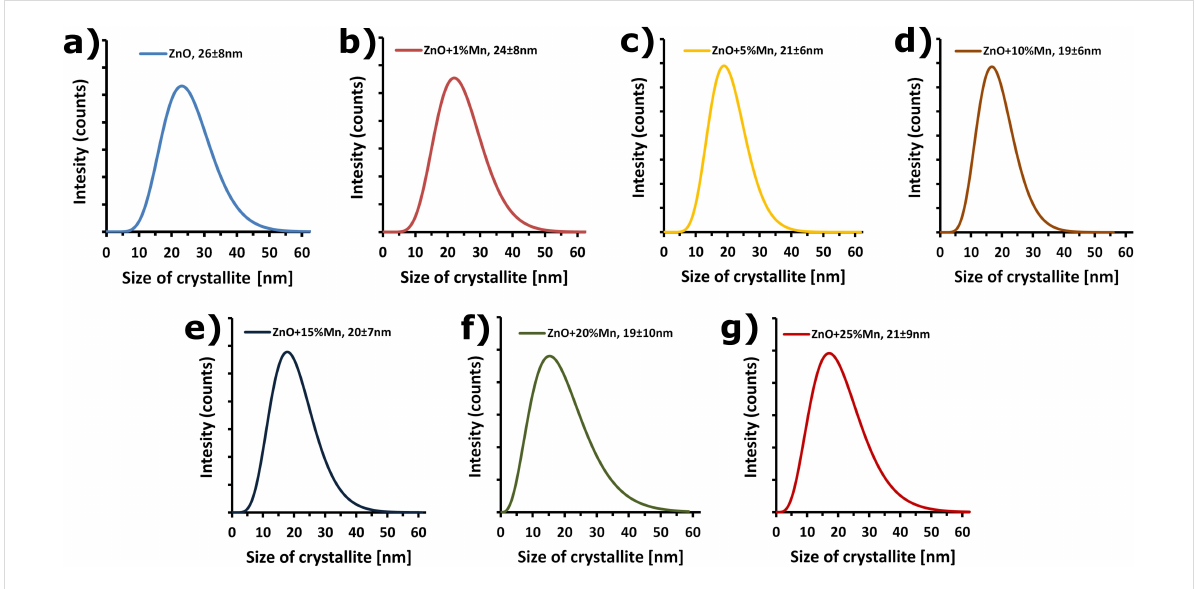
Figure 11: Crystallite size distribution obtained using Nanopowder XRD Processor Demo [68].